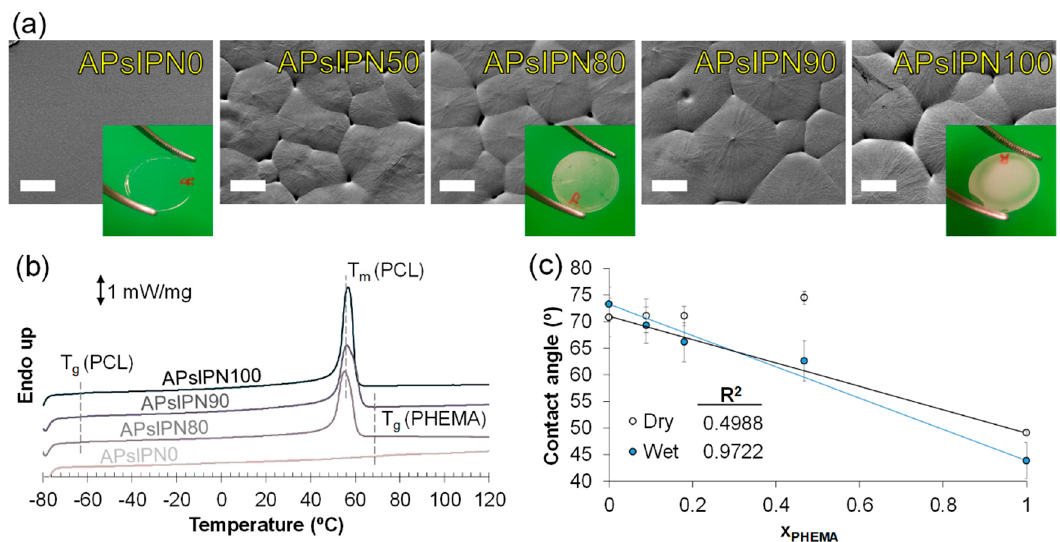
Figure 1. Topography and properties of APsIPN substrates. ( a ) SEM micrographs of amphiphilic semi-interpenetrated (sIPN) substrates with different PCL mass fractions. Details show pictures of selected substrates on coverslips. Scale bar: 20 µ m; ( b ) Calorimetry of APsIPN substrates. Melting (T m ) and glass transition temperatures (T g ) of pure homopolymers are outlined; ( c ) Contact angle of substrates with different PHEMA moieties in dry (void) and swollen (blue) conditions. Notice that the x-axis represents molar fraction (x), instead of mass fraction ( ω ).